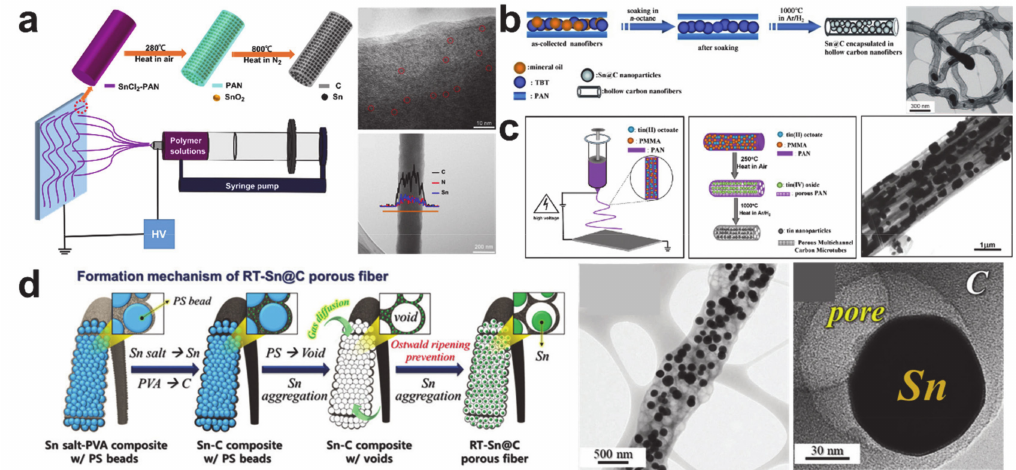
Figure 14. Processing routes and morphologies of metallic Sn / carbon composite anode